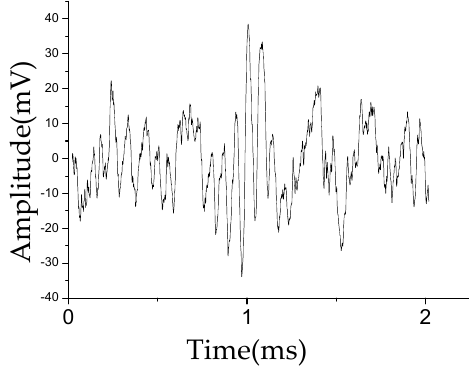
Figure 10. Lamb wave damage-scattered signal S (t) waveform.